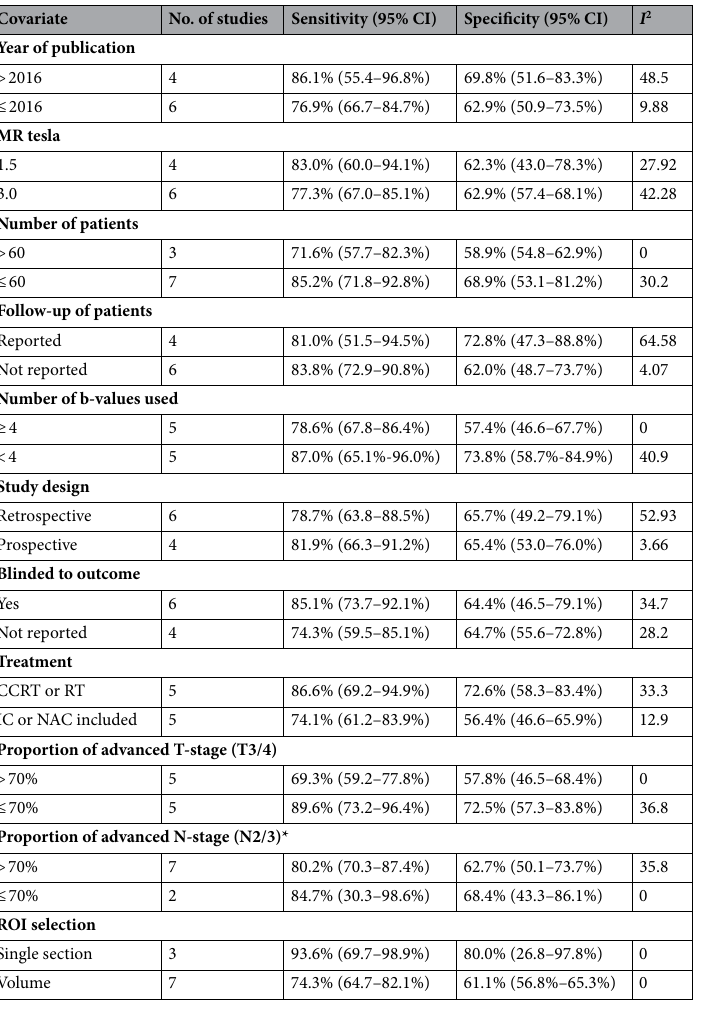
Table 3. Subgroup meta-regression analyses for identifying heterogeneity. CCRT, concurrent chemoradiation therapy; ROI, region of interest; RT, radiation therapy; IC, induction chemotherapy; NAC, neoadjuvant chemotherapy. *Law et al. did not report N-stage of patients and not